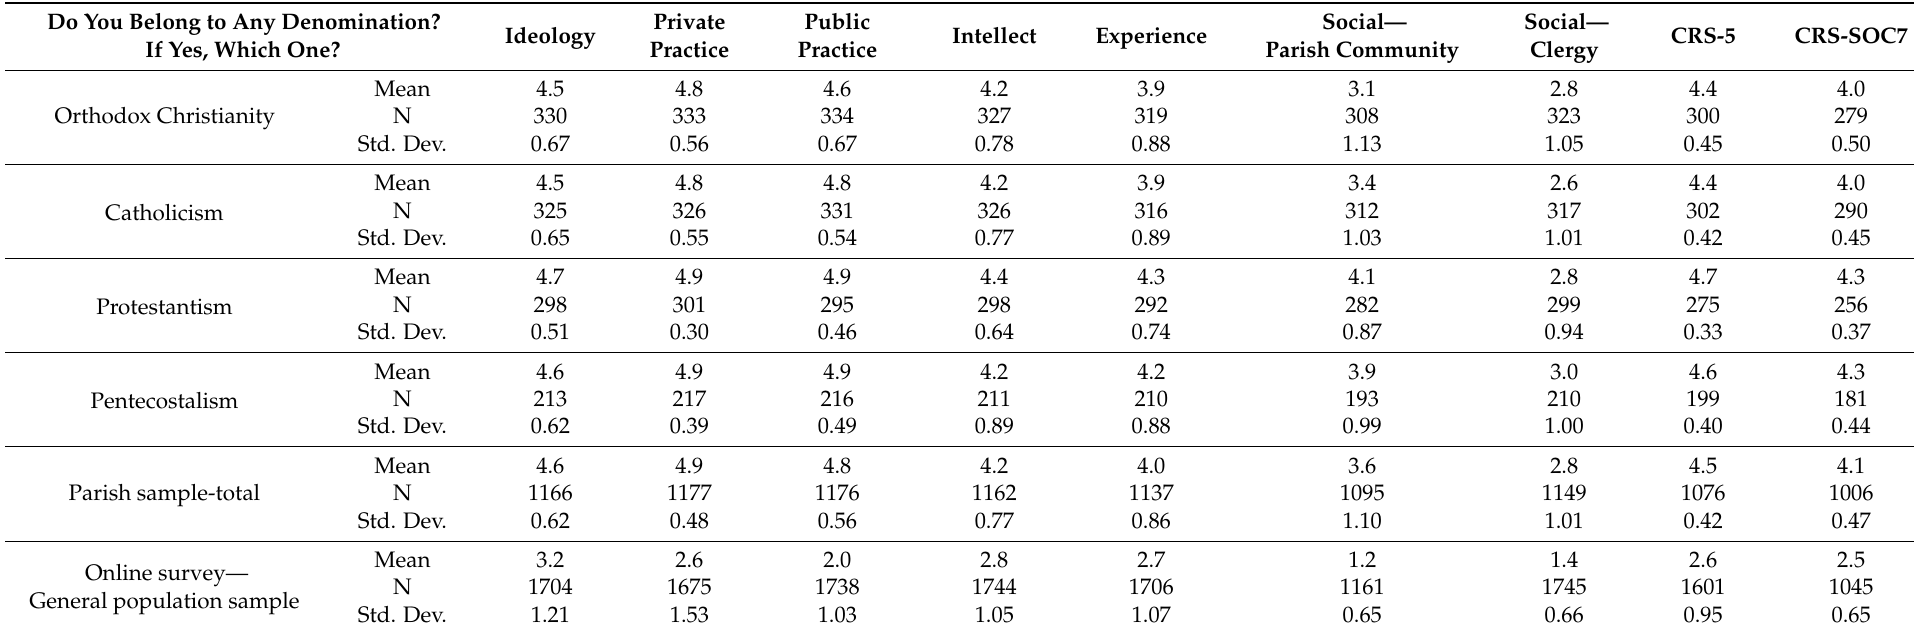
Table 7. Average values for the CRS-SOC items and total centrality